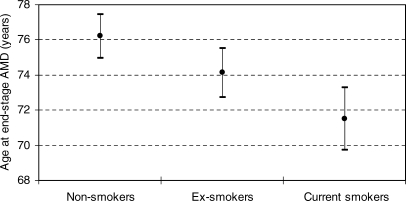
Age of End-Stage AMD According to Smoking StatusShown are means ± 95% confidence intervals of each group.